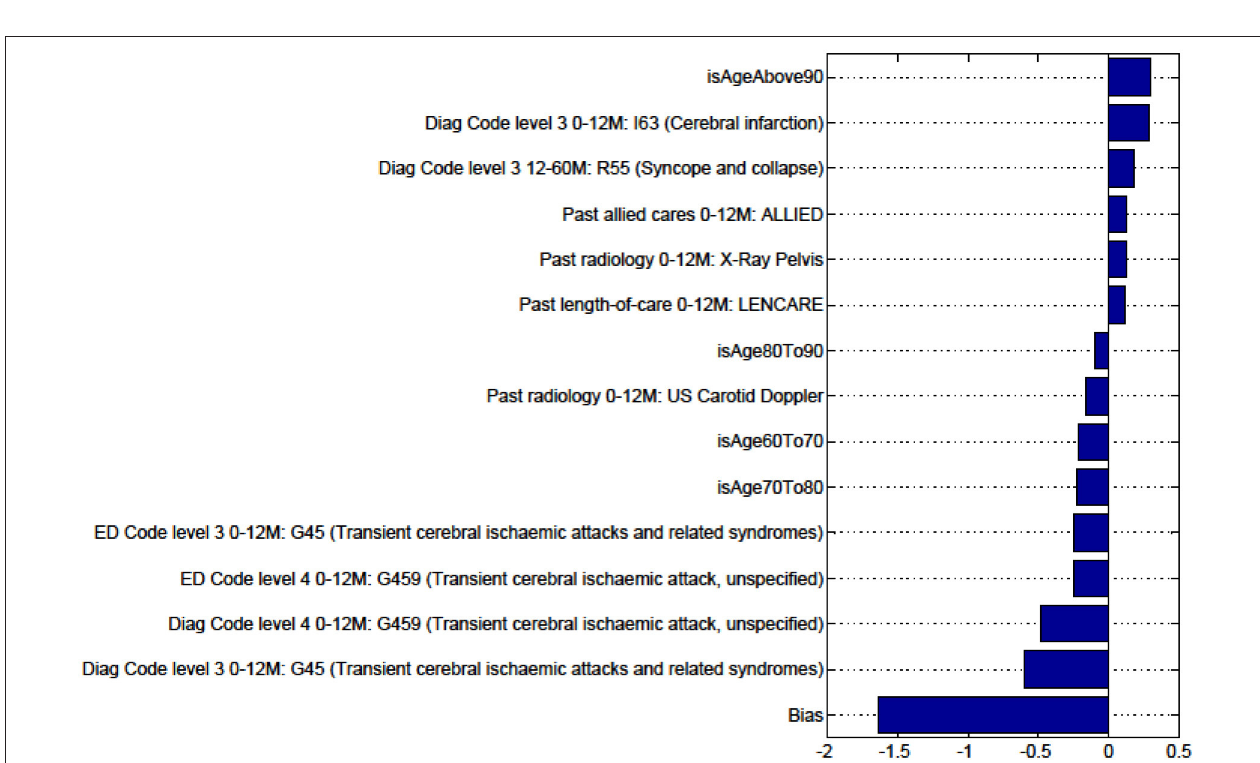
FIGURE A10 | Factors for prediction of Discharge to Rehabilitation vs Home for the sub-cohort with TIA.